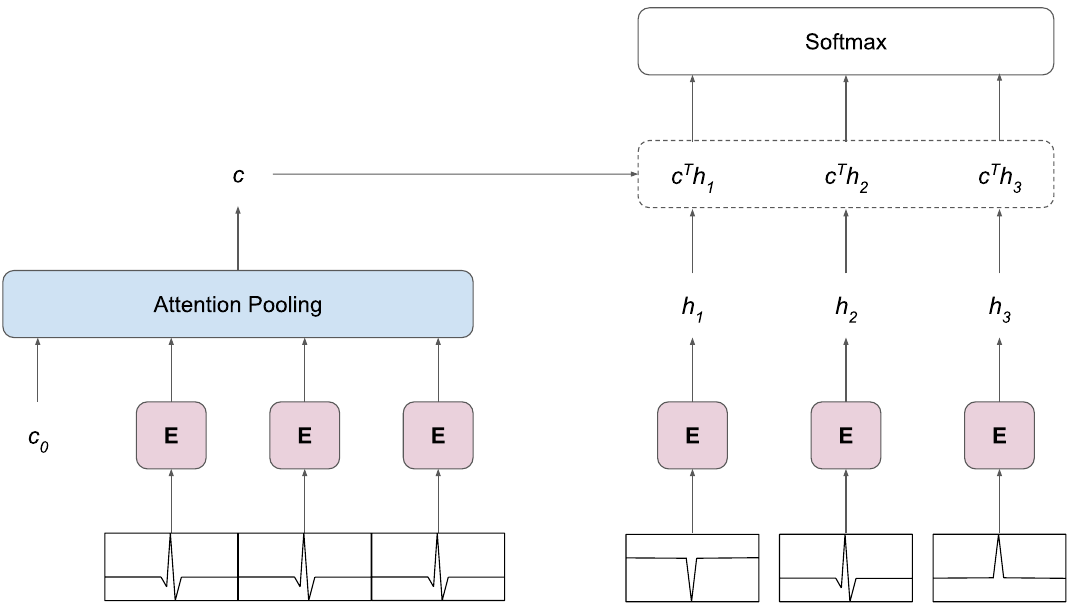
Figure 2. Architecture of the future prediction framework. The model predicts the correct future frame among negative samples (right) based on the present frames (left). Encoder E extracts features from ECG frames, producing a feature vector for each frame. Attention pooling summarizes feature vectors into a single context vector c describing the present. A dot product between c and frame encodings h i gives the similarity between the context and future frames. The entire model is trained end-to-end with gradients backpropagated from the cross-entropy loss of classifying the future frame